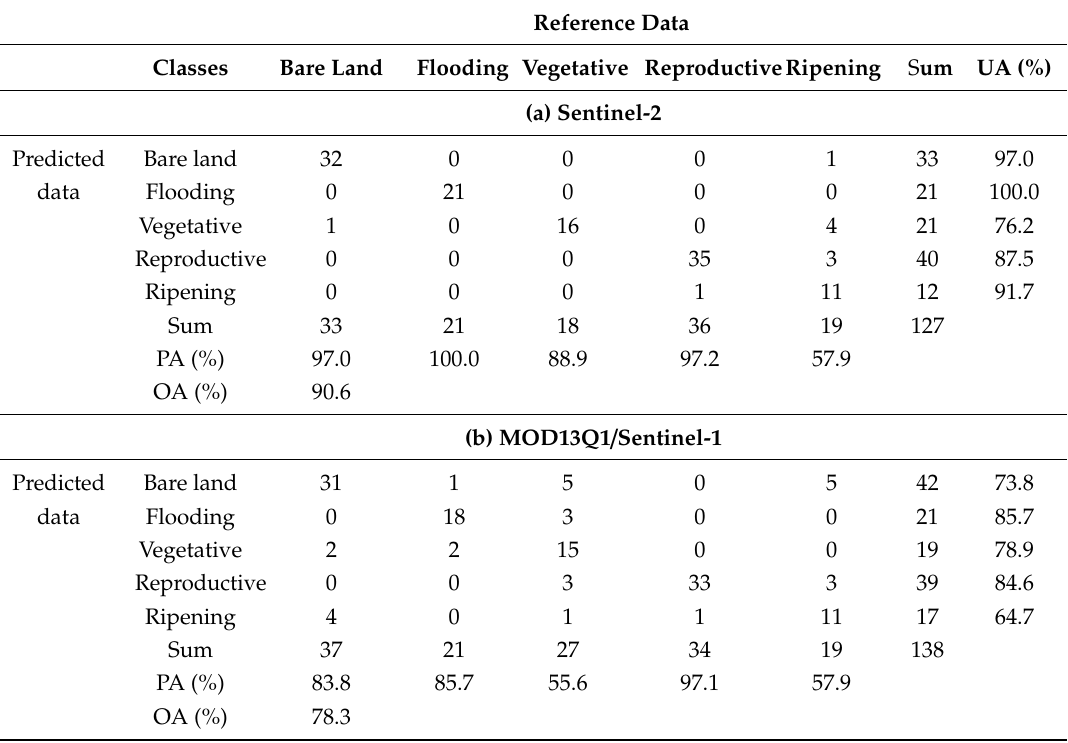
Table 1. The confusion matrix performance on the test dataset on Sentinel-2 and MOD13Q1 /